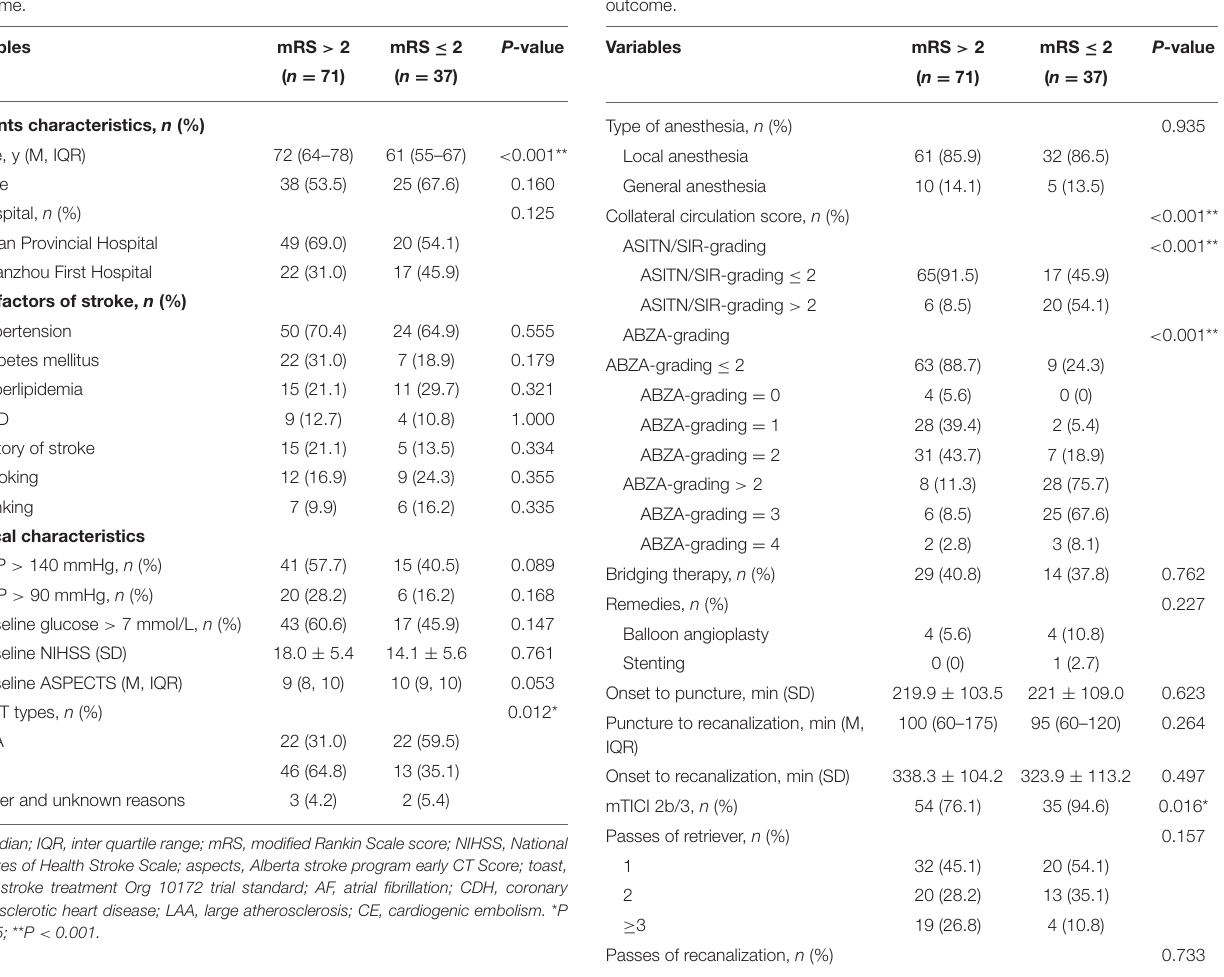
TABLE 2 | The EVT related variables of patients with and without a favorable outcome. Variables